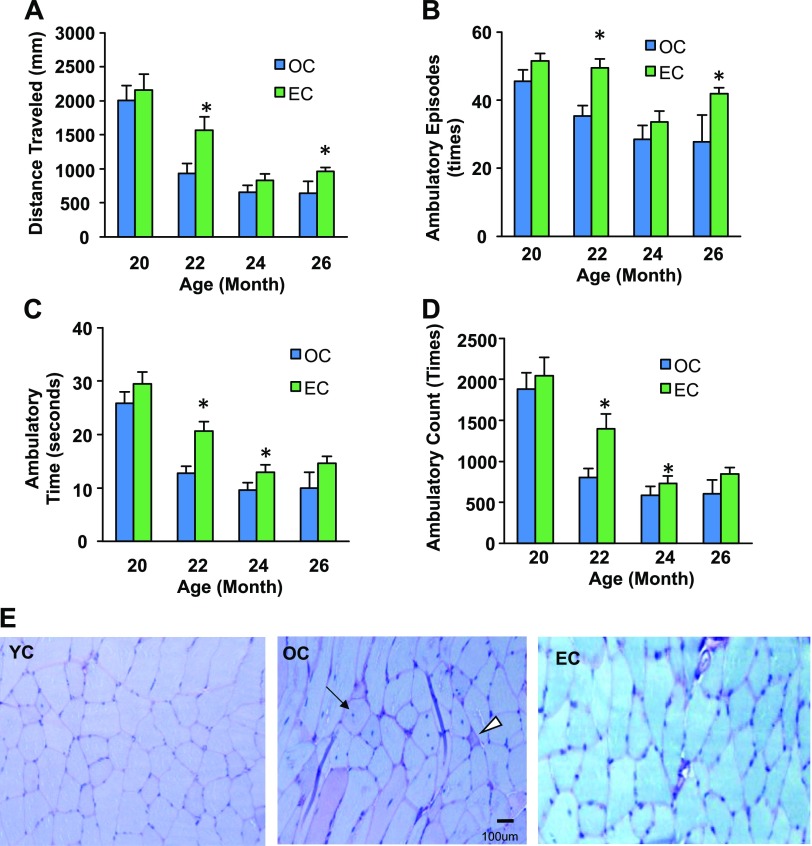
Effects of dietary epicatechin on physical activity and SkM pathology. Twenty-month-old male C57BL/6 mice were treated with EC (0.25% in drinking water) or control (OC) for 9 mo (37 wk). A–D) Physical activity metrics [distance traveled (A), ambulatory episodes (B), ambulatory time (C), ambulatory count (D)] were tested by using a computer-controlled activity monitoring system at 20, 22, 24, and 28 mo of age (n = 12/group). E) SkM tissue (quadriceps) specimens were pathologically analyzed after H&E and PAS staining. Original magnification, ×400: Arrow indicates central nucleation; arrowhead indicates degenerating fiber. #P < 0.05 OC vs. YC; *P < 0.05 EC vs. OC. n = 12.